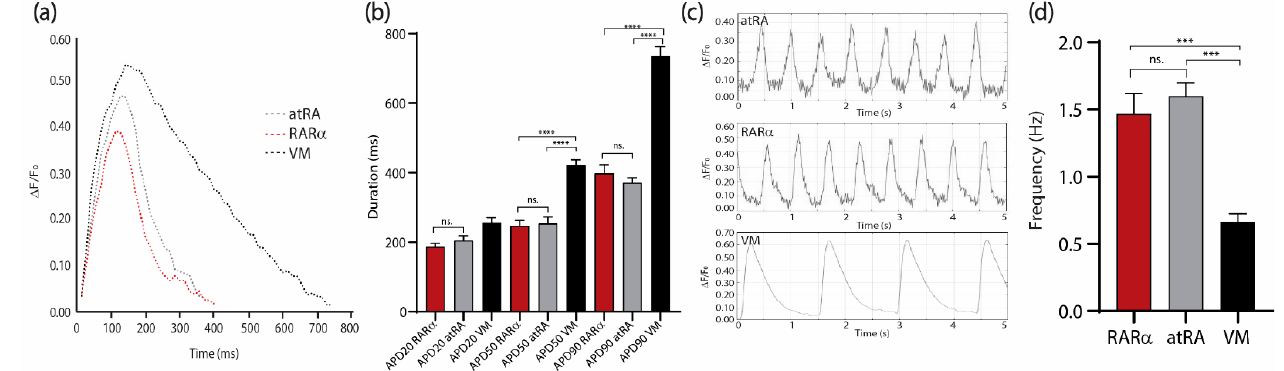
Figure 6. Electrophysiological characterization of sorted COUP-red atRA and RAR α -induced AMs compared to sorted VMs at day 21 of differentiation. ( a ) Changes in AP morphology indicated by changes in fluorescence intensity of the FluoVolt AP indicator over time in atRA (dotted gray) and RAR α (dotted red) AMs and VMs (dotted black). ( b ) Comparison of mean AP duration at 20% (APD20), 50% (APD50), and 90% (APD90) repolarization in atRA and RAR α AMs and VMs (n = 6 per condition). ( c ) AP waveforms indicated by changes in fluorescence intensity of the FluoVolt AP indicator over time in atRA (upper panel) and RAR α (middle panel) AMs and VMs (lower panel). ( d ) Contraction frequency of atRA or RAR α AMs and VMs obtained from AP waveforms (n = 6 cells); ns. = not significant. *** p < 0.001. **** p < 0.0001. All values are represented as means ± S.E.M. One-way ANOVA test is shown. AMs = atrial cardiomyocytes; VMs = ventricular cardiomyocytes.